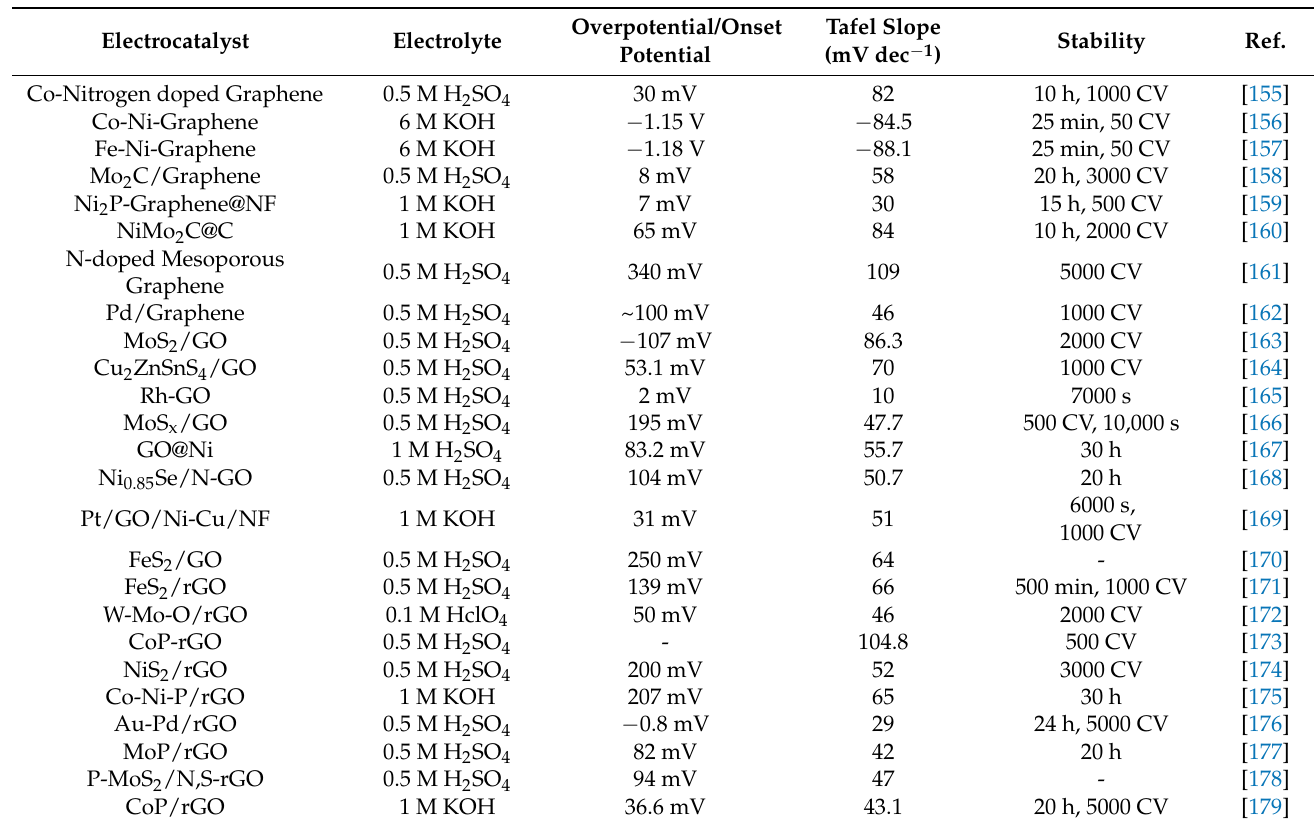
Table 4. HER activity by graphene and its derivatives based